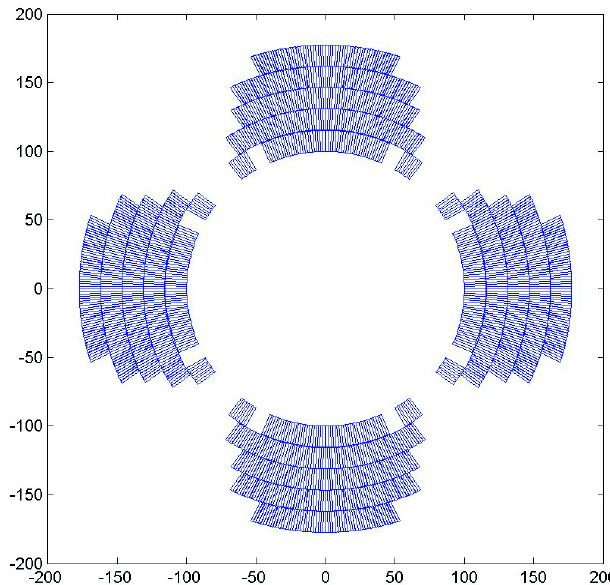
FIG. 8. (Color) Coil layout of a quadrupole with 200 mm aper- ture.